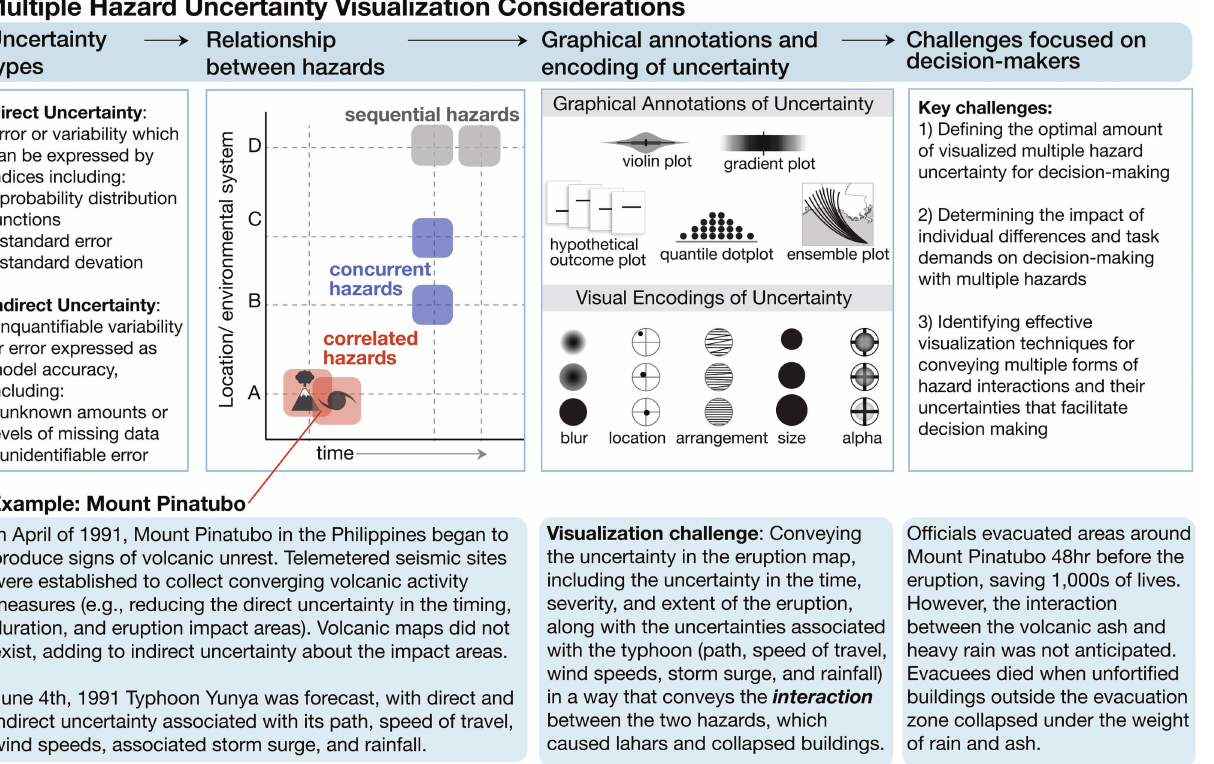
FIGURE 1 | Overview of multiple hazard uncertainty visualization considerations discussed in this paper. Uncertainty types based on discussions in Padilla et al. (2021). Relationship between hazards based on Balch et al. (2020). Summary of graphical annotations redrawn from Padilla et al. (2021). Mount Pinatubo example based on accounts in Gill and Malamud